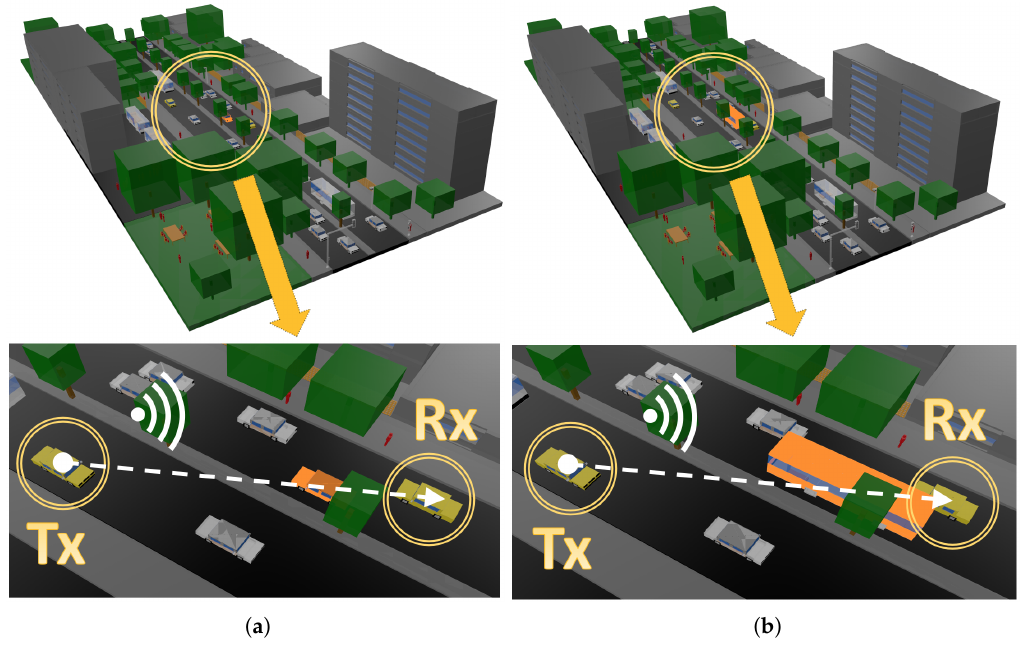
Figure 5. General and detailed view of the simulated 3D scenarios for both case studies: ( a ) V2V communication link with a blocking car, ( b ) V2V communication link with a bus